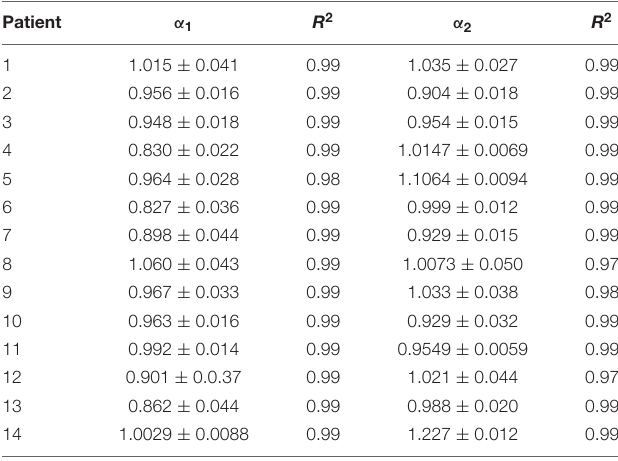
TABLE 3 | Estimated values of short-term ( α 1 ) and long-term ( α 2 ) scaling exponents in the second cluster of heart failure patients. Patient